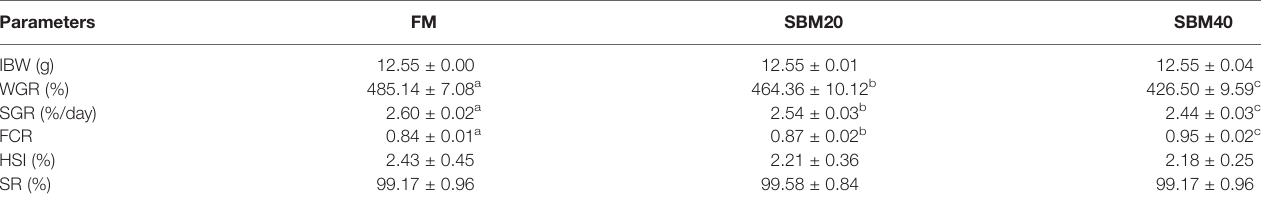
The different letters represent signi fi cant